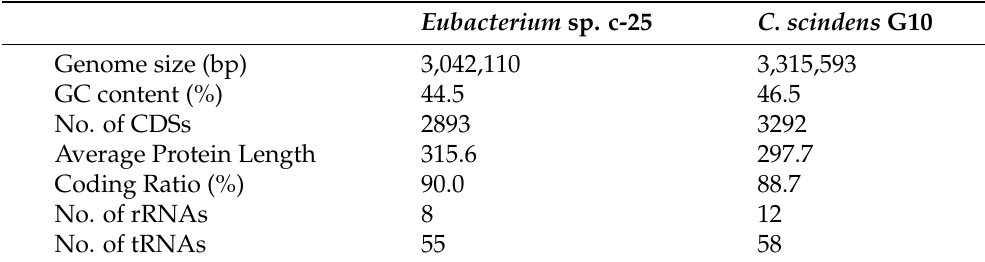
Table 2. Complete sequenced genome information.